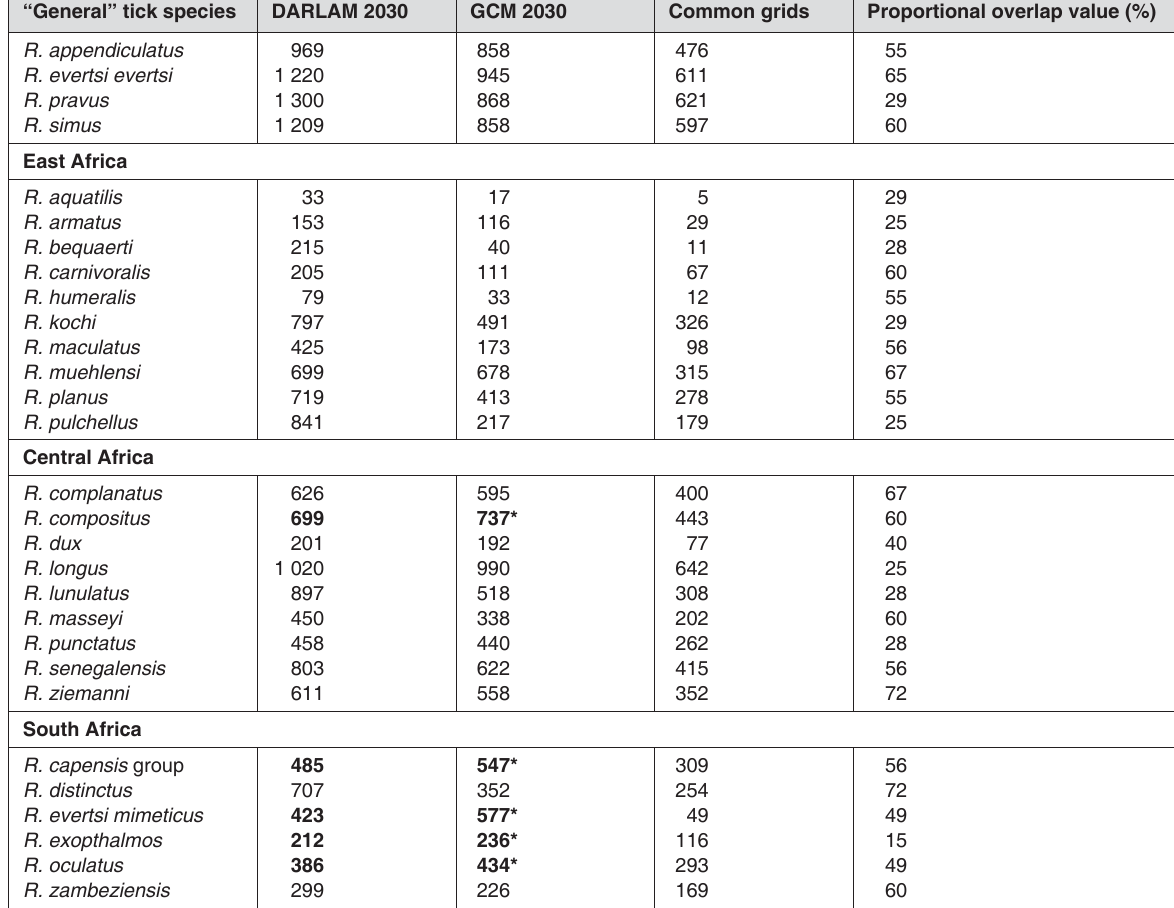
Bold * = GCM predictions wider than those of